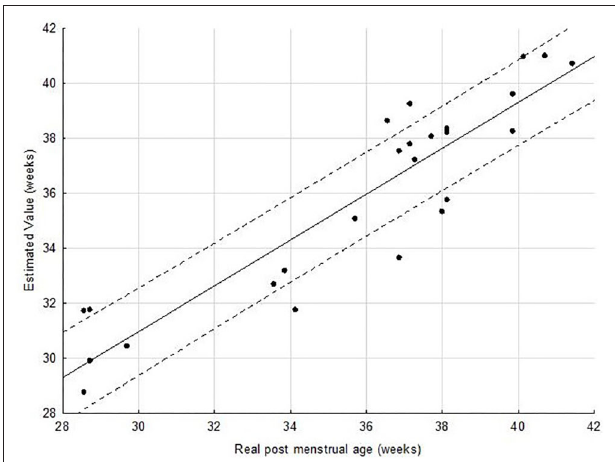
FIGURE 7 | Scatter plot of estimated brain-age against PMA. The solid line indicates the regression line and the dashed line indicates the 0.95 confidence interval of the regression line. The mean standard error of the estimate was 1.76 weeks.